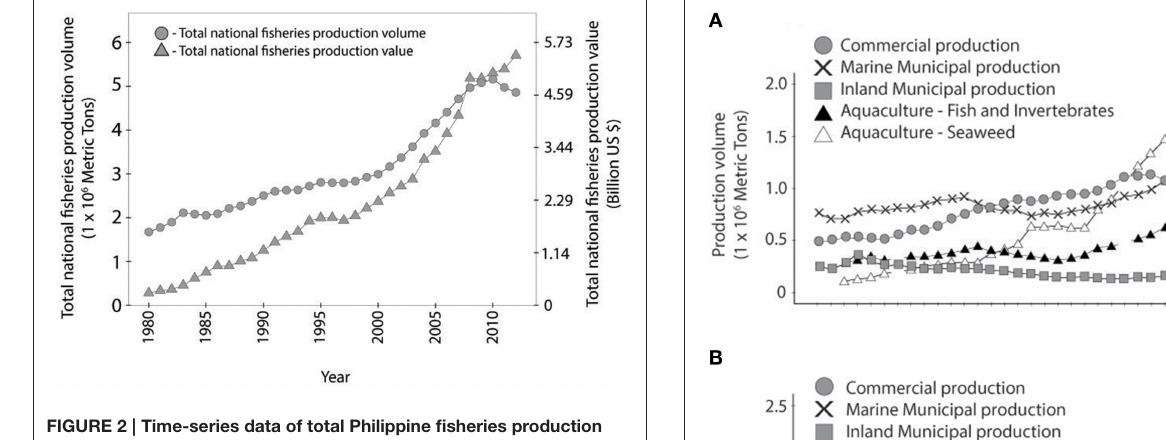
FIGURE 2 | Time-series data of total Philippine fisheries production volume and value from the years 1980–2012.